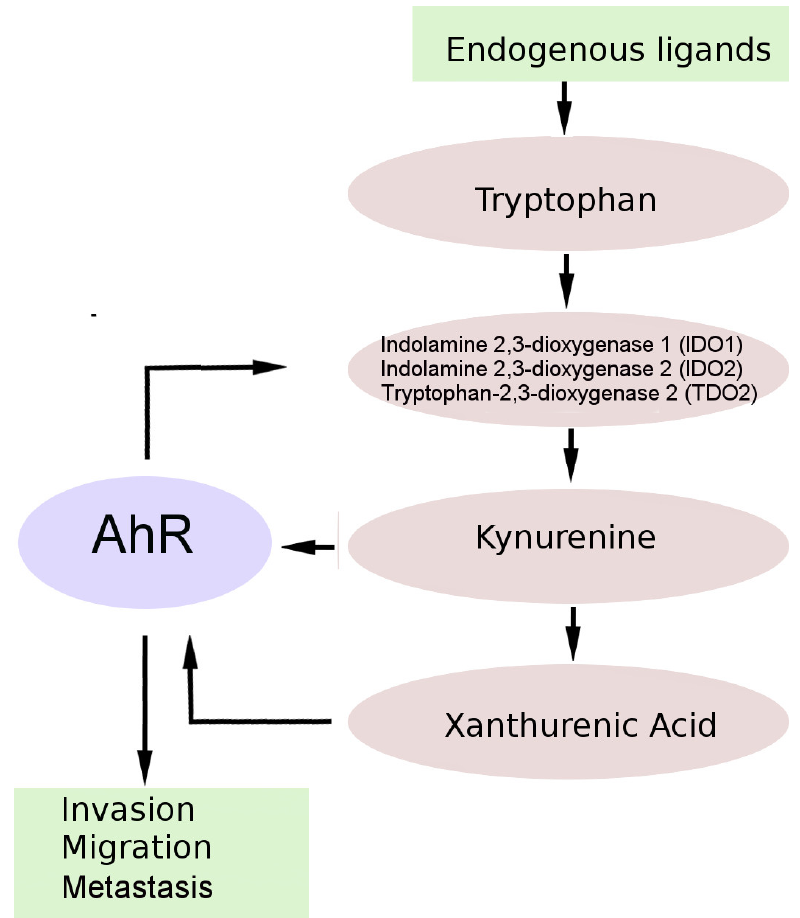
Figure 3. An endogenous tumor-promoting ligand of AhR in brain tumor cells. AHR in tumor cells is chronically activated by kynurenine pathway metabolites, including kinurenine and xanthurenic acid. AHR activation leads to increased regulation of genes associated with tumor cell invasion, migration, and metastasis. AHR also enhances the expression of IDO and/or TDO in malignant cells, resulting in continuous production of endogenous AHR ligands.